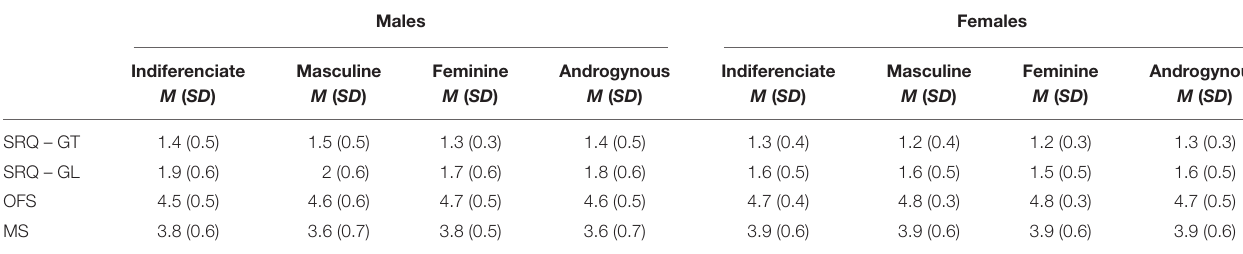
TABLE 9 | Descriptive statistics of males ( n = 176) and females ( n = 524) across gender stereotypes classification. Males Females Indiferenciate Masculine Feminine Androgynous Indiferenciate Masculine Feminine Androgynous M ( SD